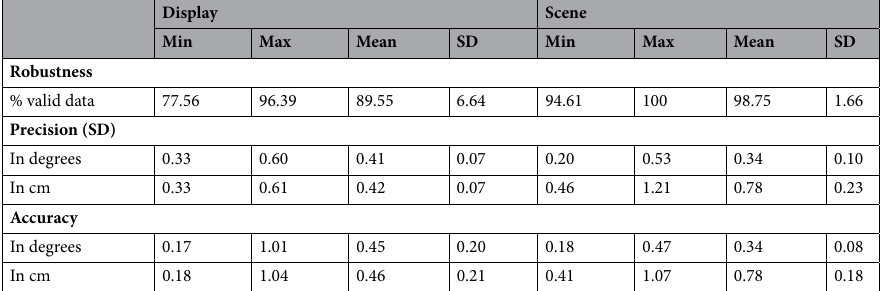
Table 1. Eye tracking robustness, precision and accuracy under standard laboratory conditions for a standard display setup (display condition) and the scene-based setup (scene condition). Values in degrees of visual angle and cm. Precision (SD) = standard deviation of data samples (Holmqvist et al.,